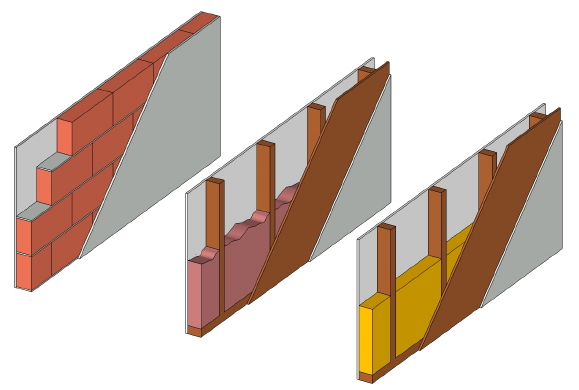
Figure 1. Schemes of tested walls: masonry (left), timber with recycled infill (center), timber with min- eral wool